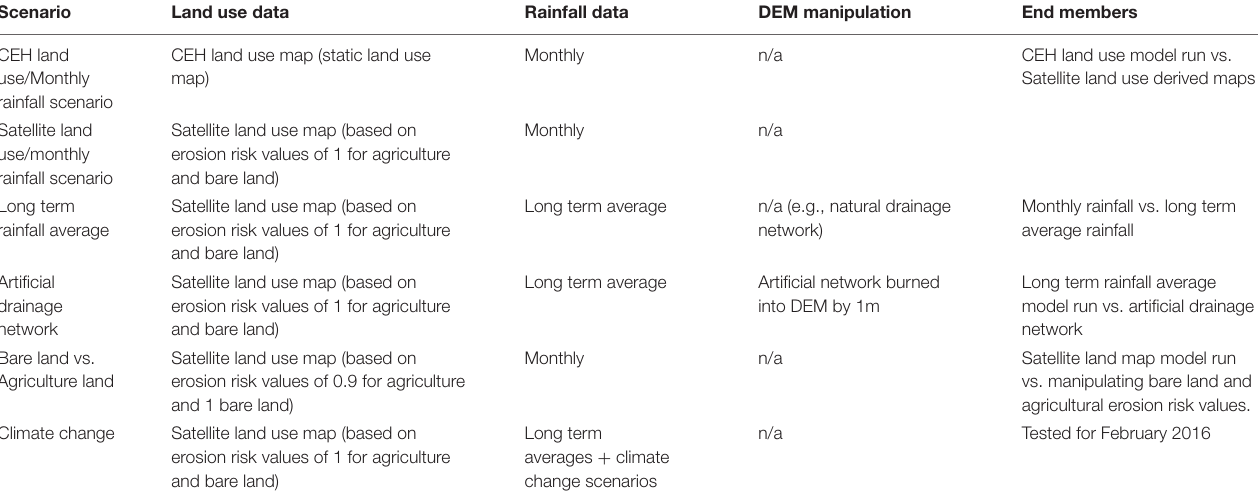
TABLE 1 | Modeling scenarios and data